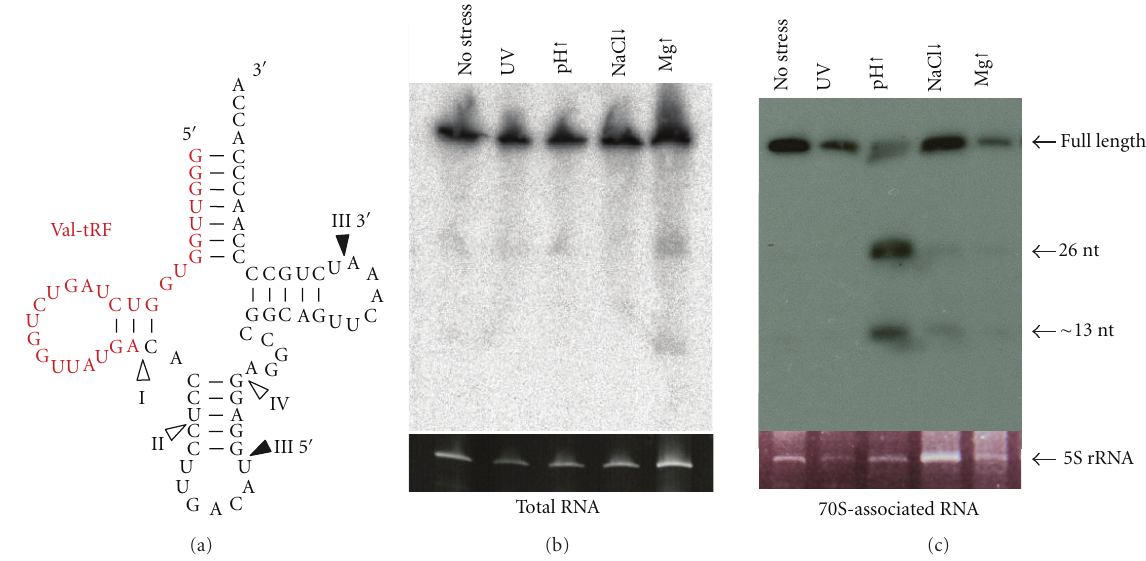
Figure 1: Processing and expression of Val-tRF. (a) Secondary structure of H. volcanii Val-tRNA with the Val-tRF depicted in red. Arrowheads indicate the processing positions for the four di ff erent observed tRF classes (I–IV). Open arrowheads on the Val-tRNA structure indicate the 3 (cid:2) ends of the tRFs for class I, as well as the analogous positions for the other tRF classes II, and IV. tRFs from classes I, II, and IV are all processed from the 5 (cid:2) end of mature tRNAs. Filled arrowheads mark the 5 (cid:2) and 3 (cid:2) ends of tRFs derived from class III. Northern blot analyses for Val-tRF were performed using (b) total RNA or (c) ribosome-associated RNA. RNA was isolated from unstressed H. volcanii cells (no stress), or cells grown under di ff erent permanent environmental stress conditions (ultraviolet stress (UV), high pH (pH ↑ ), 0.9 MNaCl (NaCl ↓ ), 300mMMgSO 4 (Mg ↑ )). Arrows indicate the full-length tRNA and the detected processing products. In all panels 5S rRNA served as internal loading